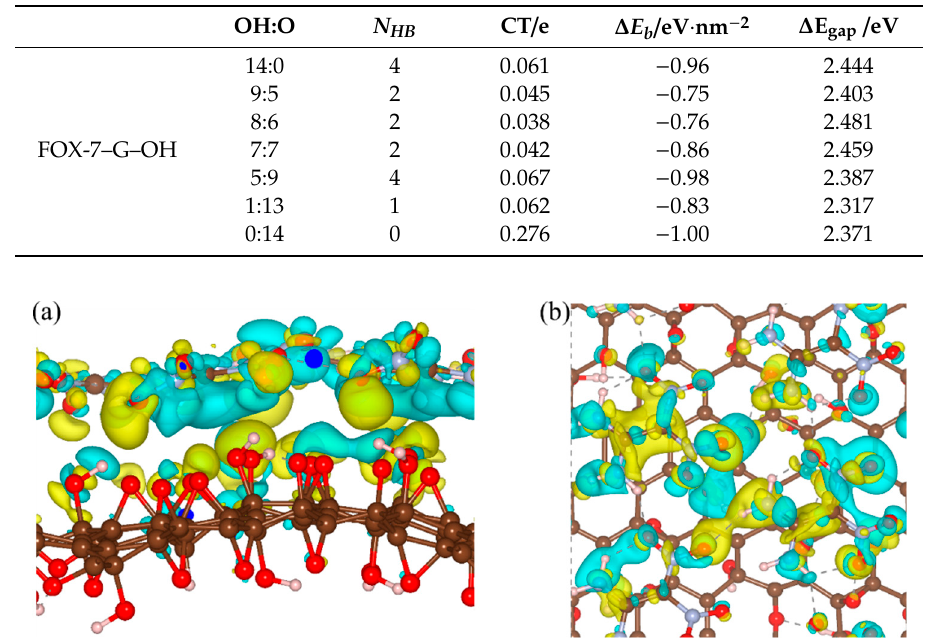
Figure 4. ( a ) Side view and ( b ) top view of charge density differences of the FOX-7–GO composite with OH:O = 9:5 oxygen-containing groups. Gray, red, and white balls represent carbon, oxygen, and hydrogen atoms, respectively. Isosurface levels were set at 0.0015 Bohr − 3 ; cyan: charge accumulation; yellow: charge depletion.